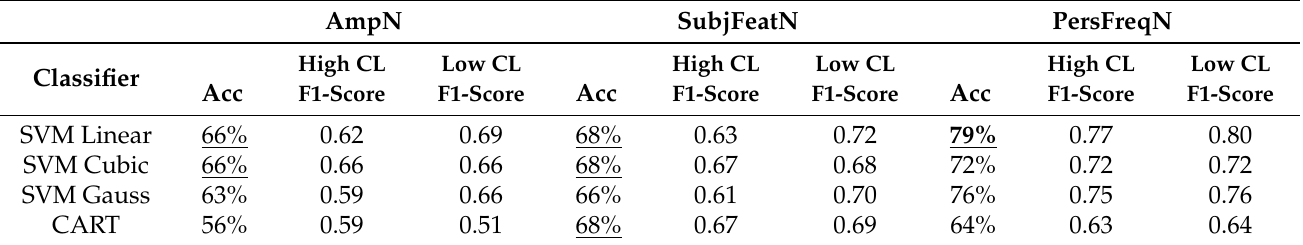
Table 5. Performance comparison on the CLAWDAS Young dataset, varying the normalization strategies (columns) and classification models (rows). Two performance metrics are evaluated using a LOSO validation strategy: Accuracy (Acc) and single-class F1-score. The best performances reached for each type of normalization are underlined, while the the highest accuracy value of all is highlighted in bold.